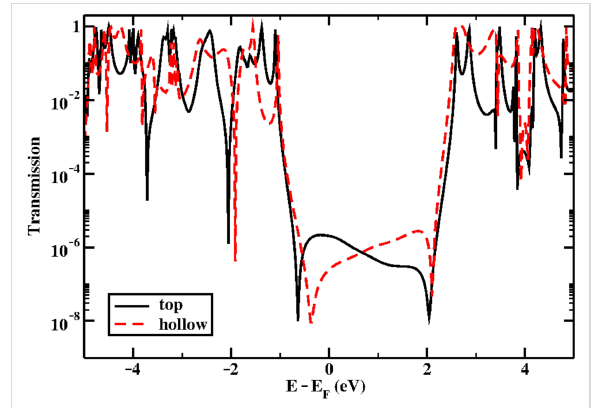
Figure 9: Transmission as a function of energy for the top and hollow binding geometries.